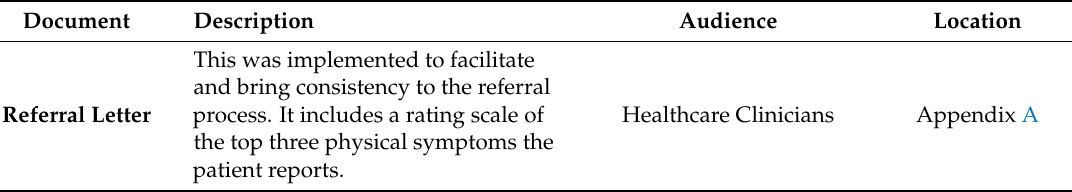
Table 2. Documents for Clinicians and